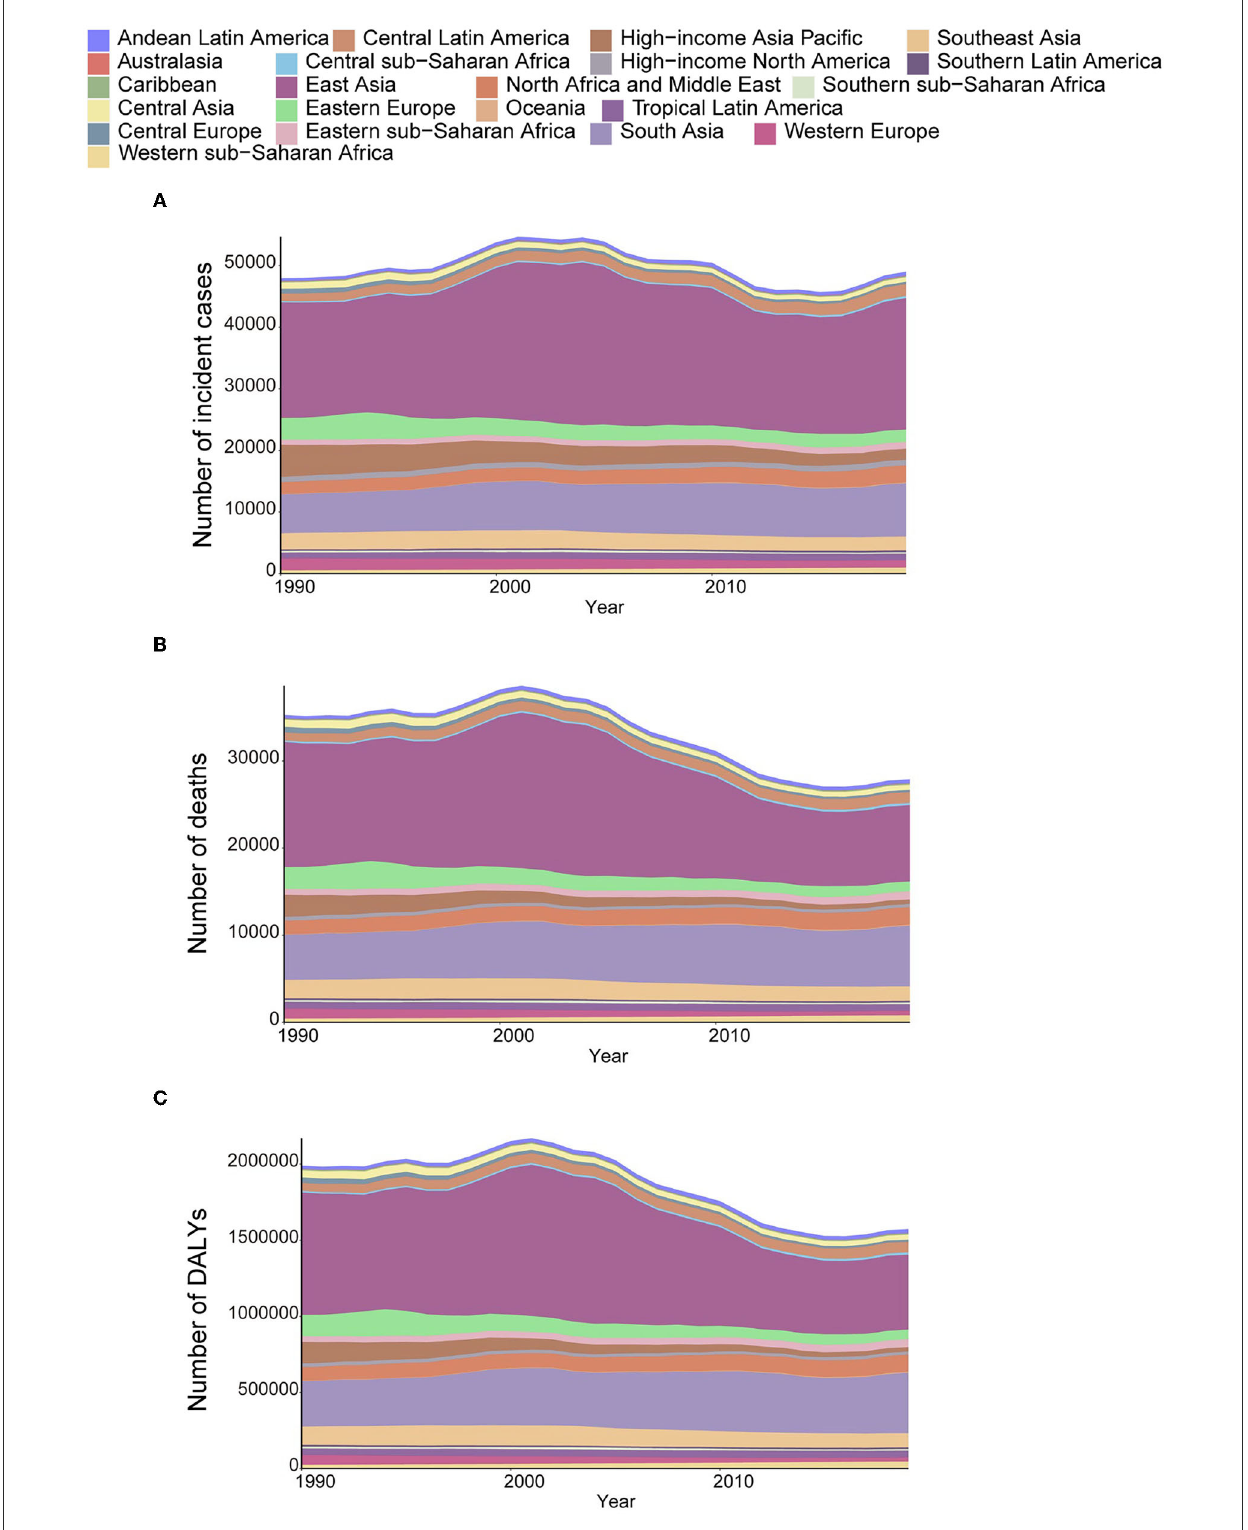
FIGURE4 The absolute number of incident cases (A) , deaths (B) , and DALYs (C) due to AYA stomach cancer, 1990–2019, for 21 GBD